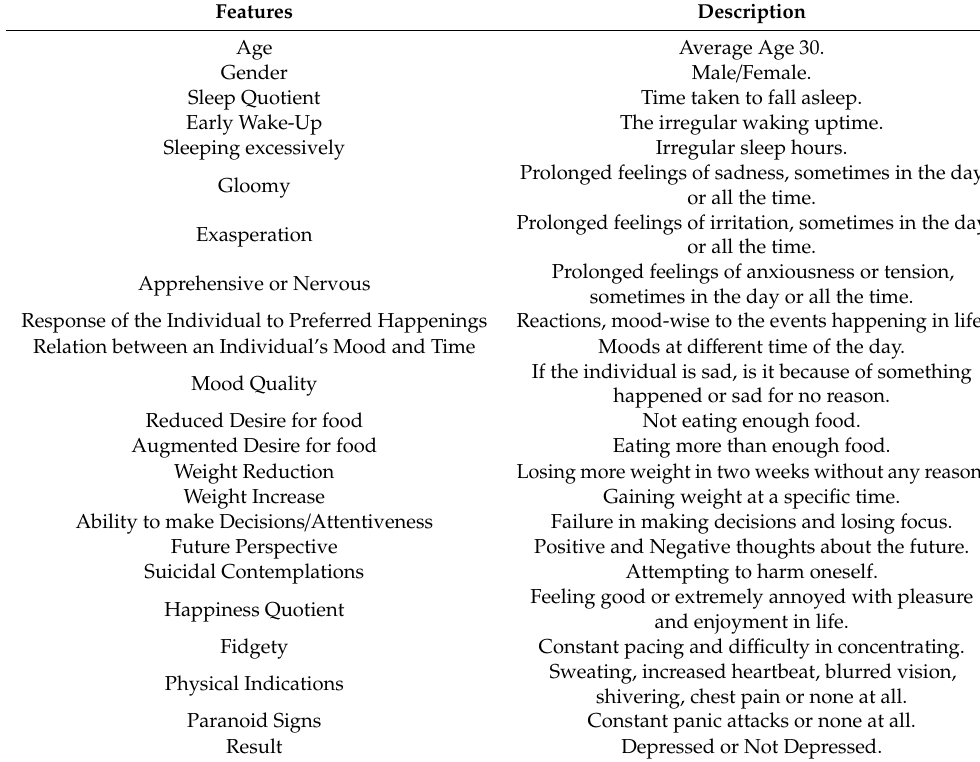
Table 1. The portrayal of essential